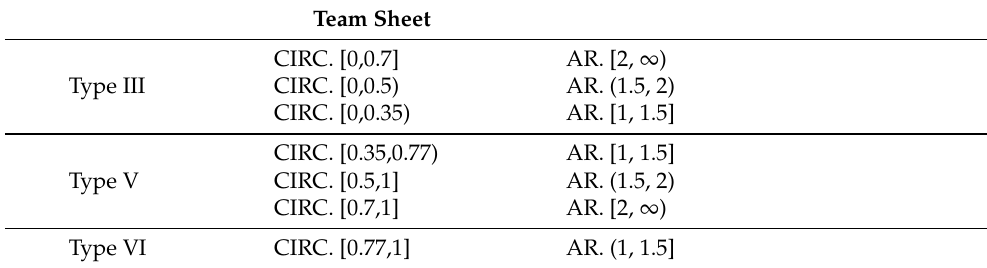
Table 1. Nodule-type classification rules indicating the belonging group.